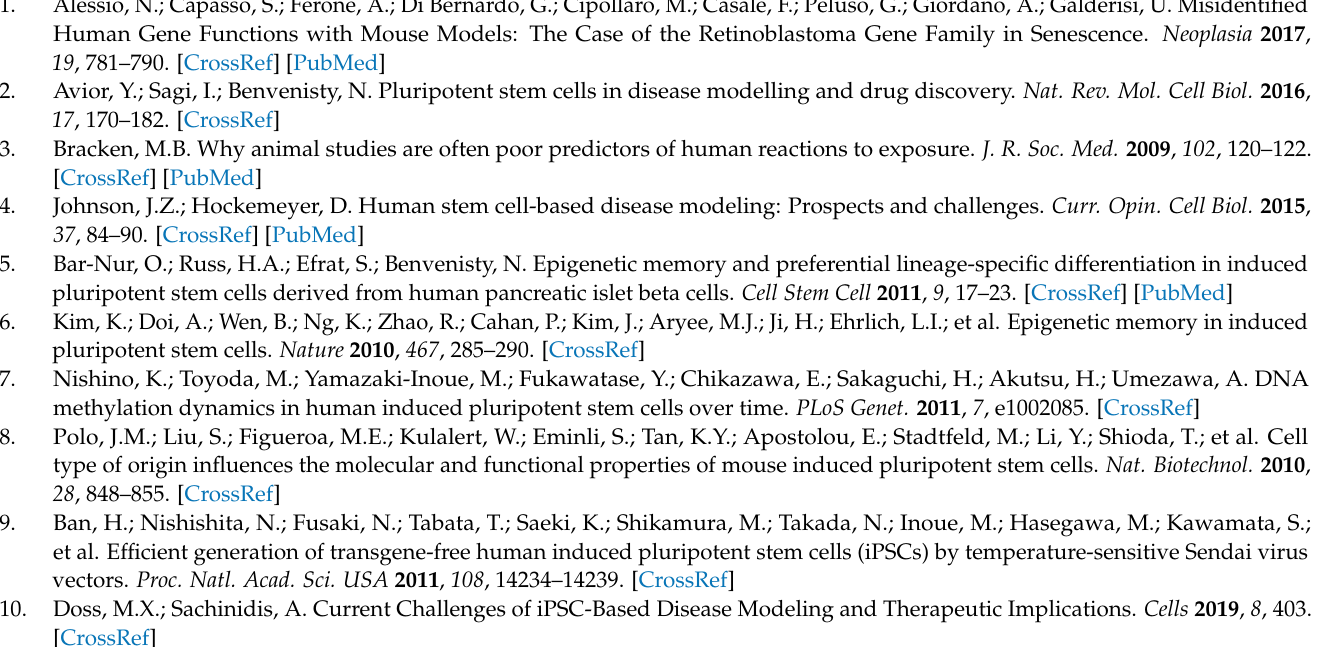
patients with ID. Figure S2: Negative controls of immunostaining experiments. Figure S3: Validation of the primers for detection of stemness, lineage specification, and differentiation